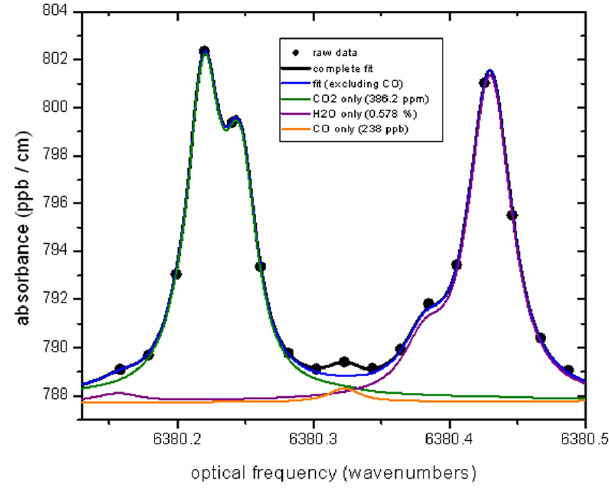
Figure 1. Spectral fits of absorption data (black solid dots) for CO 2 (four overlapping lines) only, H 2 O (three lines) only, CO only, ex- cluding CO, and all data. From Chen et al.